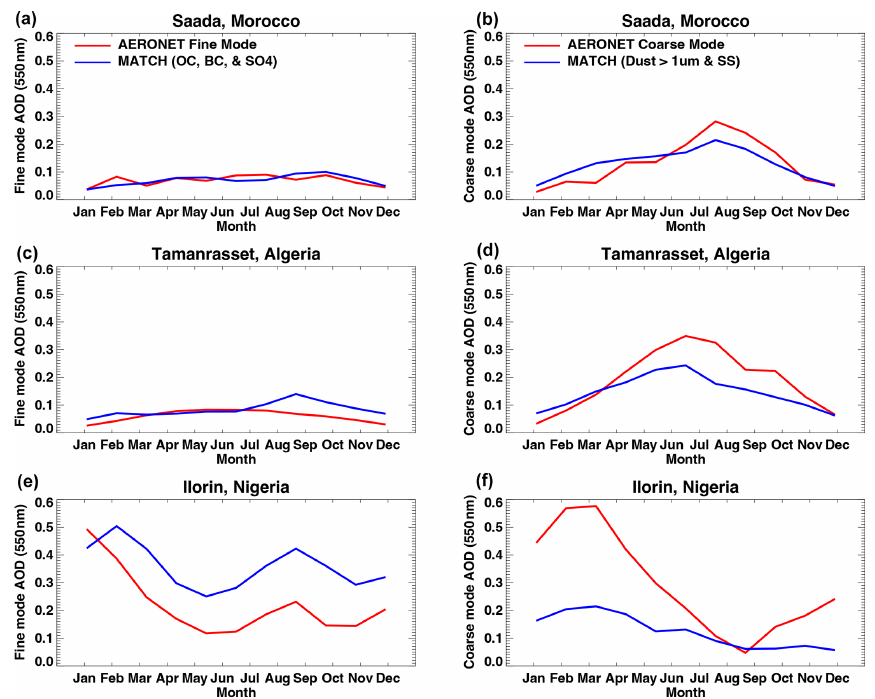
Figure 16. Canonical monthly means across 20 years (2000–2020) showing AERONET fine-mode (a, c, e) and coarse-mode (b, d, f) AOD at 550nm compared with MATCH constituents. MATCH values represent summations of organic carbon (OC), black carbon (BC), and sulfate (SO 4 ) for fine-mode comparisons, and they represent large dust particles ( > 1µm) and sea salt for coarse-mode comparisons. Table 7. Radiative flux, aerosol optical depth (AOD), precipitable water, and surface albedo change to match observed TOA radiative fluxes. Changes: adjusted − unadjusted Site Observed Clear-sky Clear-sky Clear-sky Clear-sky Clear-sky TOA TOA surface AOD precipitable surface upward upward downward water (cm) albedo shortwave shortwave shortwave irradiance irradiance irradiance Midlatitude